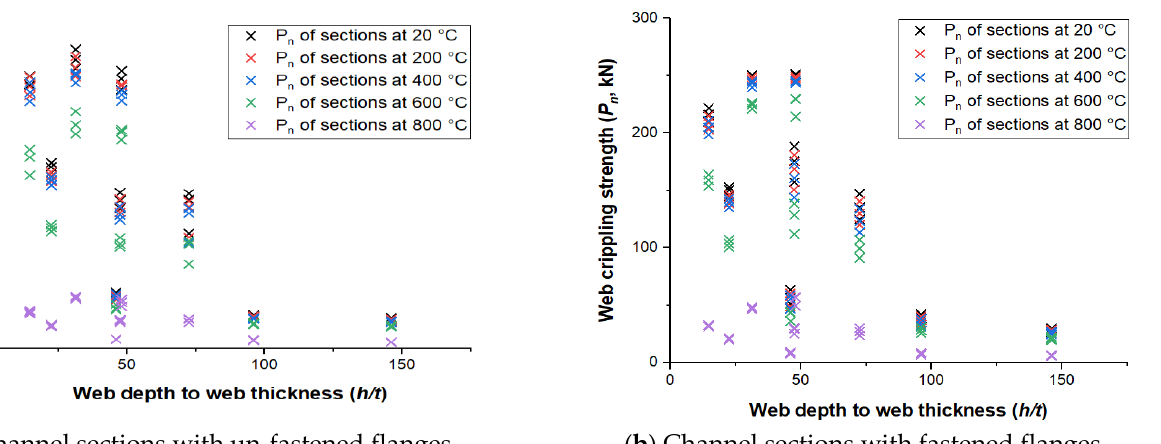
Figure 12. Comparison of web crippling strength of unfastened and fastened flanges.